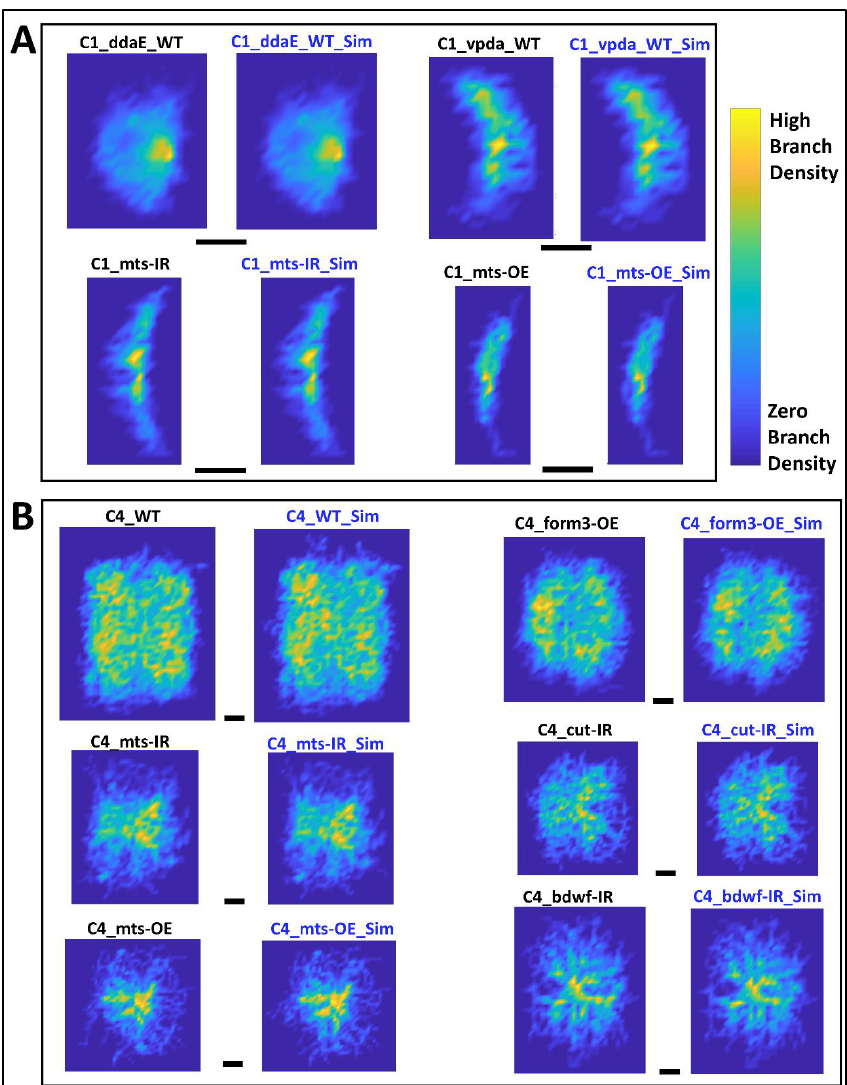
Figure 7. Average Arbor Density of Real and Simulated Neurons. ( A ) Arbor density averaged across all neurons from each group for Class I neuron types (ddaE WT, vpda WT, vpda mts-IR, and vpda mts-OE). Heatmaps for both real (left) and simulated (right) neurons are provided for each group. ( B ) Arbor density averaged across all neurons from each group for six Class IV neuron groups (WT, form3-OE, mts-IR, cut-IR, mts-OE, and bdwf-IR). Black scale bars below each real-simulated neuron pair represent 100 µm. Heatmaps for both real (left) and simulated (right) neurons are provided for each group, where yellow in the color bar represents high branch density and blue in the color bar represents low to zero branch density. The heatmaps for the 7 remaining Class IV neuron groups are included in Supplementary Materials Figure S2.